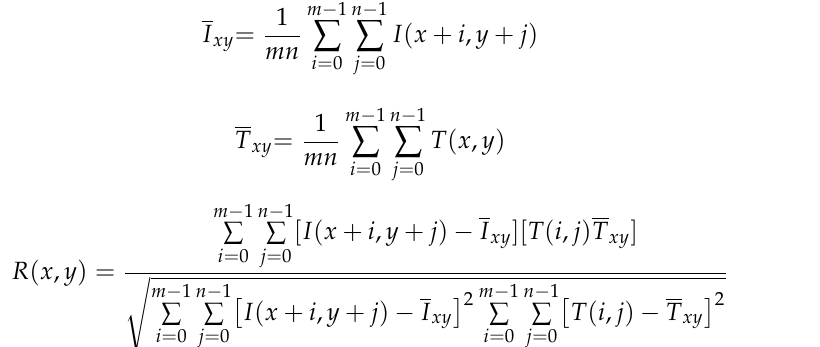
Figure 3. There are three operations of pre-processing of ADMTCF: ( a ) the first one is to select the object in the first frame; ( b ) the second one is to convert the object’s image from the RGB color domain to the HSV color domain; ( c ) the third one is to carry out LBP encoding.